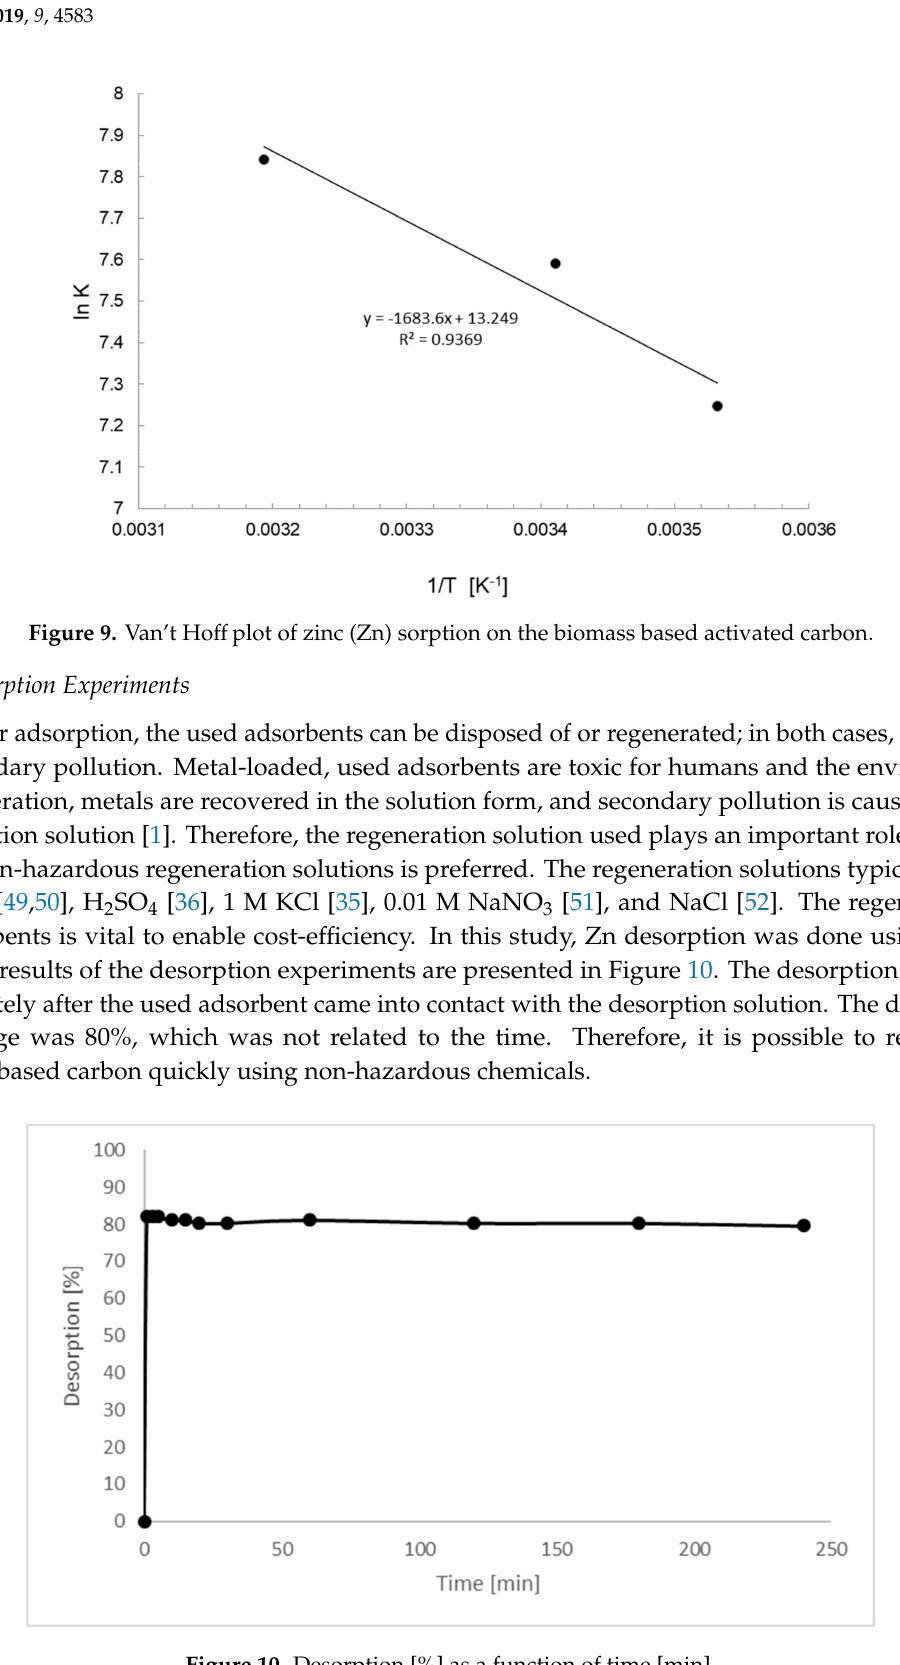
Figure 10. Desorption [%] as a function of time